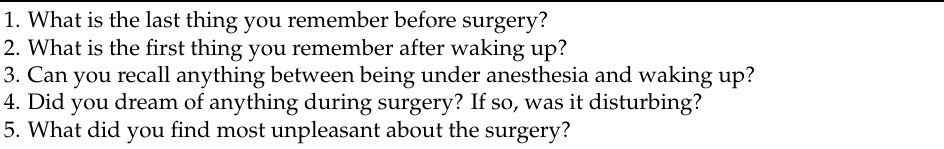
Table 1. A modified Brice